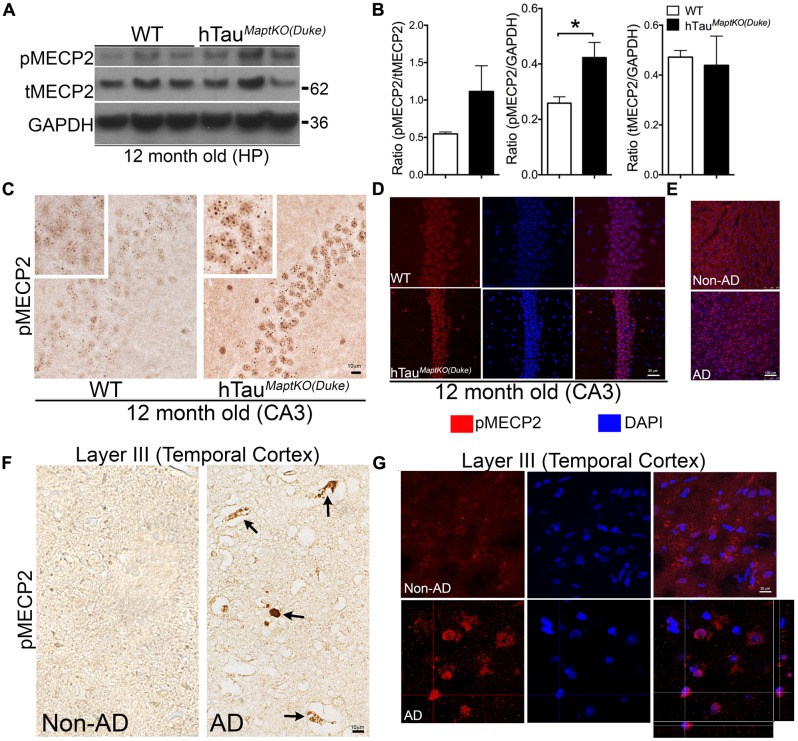
MECP2 phosphorylation is up-regulated in 12-month-old hTauMaptKO(Duke) mice and in human AD brain.
(A,B) Western blot analysis showing pMECP2/GAPDH ratio significantly higher [∗p < 0.05; unpaired t-test; n = 3 for hTauMaptKO(Duke) versus WT mice; all three males for WT; two males and one female for hTauMaptKO(Duke); mean + SEM] in the hippocampus of 12-month-old hTauMaptKO(Duke) mice compared to WT controls. No alteration in the tMECP2/GAPDH ratio in the hippocampus of 12-month-old hTauMaptKO(Duke) mice compared to controls. (C) Significantly elevated pMECP2 immunoreactive specks within the nucleus of CA3 hippocampal neurons of 12-month-old hTauMaptKO(Duke) mice compared to age-matched WT controls. (D) Double IF and confocal microscopy analysis shows a modest increase in the pMECP2 in the CA3 neuronal layer of 12-month-old hTauMaptKO(Duke) mice compared to age-matched WT controls. (E–G) Confocal projections (in E,G) and bright field images show elevated pMECP2 immunoreactivity and co-localization with nuclear stain DAPI (in E,G) or peri-vascular labeling (in F) specifically in the Layer III of temporal cortex of human AD brain autopsy sections compared to the to non-AD healthy control subject. Orthogonal view in (G) shows pMECP2 labeling to be nuclear or peri-nuclear in the human AD cortex. Scale bar 10 μm (in C,F); 25 μm (in D,G); 100 μm (in E).